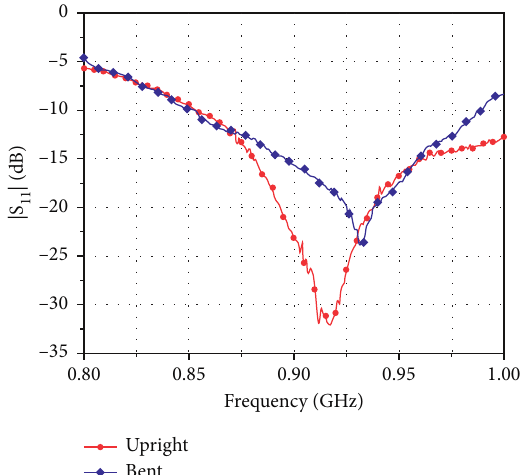
Figure 4: Influence of the flexible cable on |S antenna.